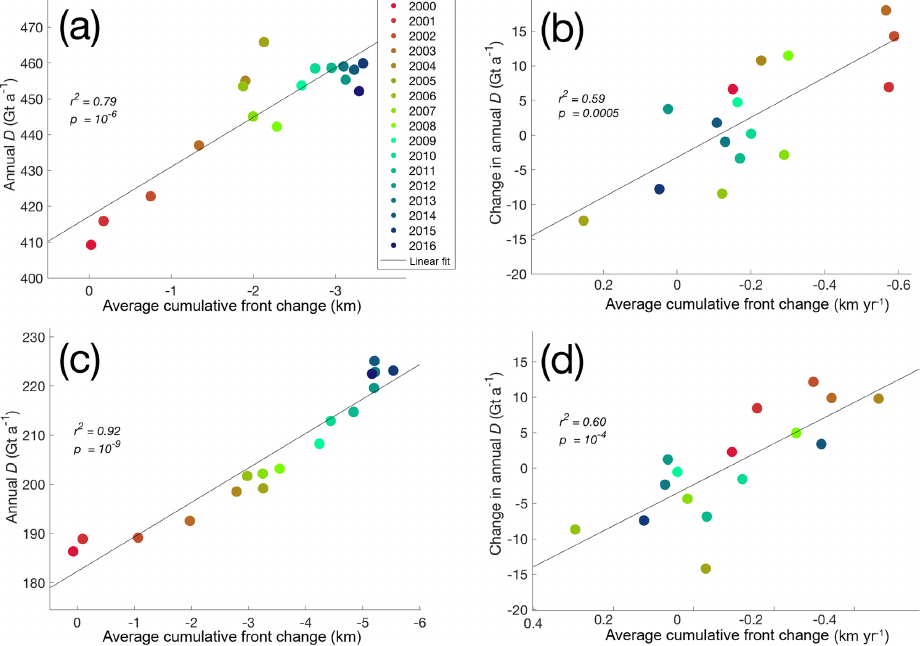
Figure 5. (a) Colored dots are GrIS-wide cumulative average front position change since 1 January 2000, with negative values indicating retreat, versus annual average discharge, D , for each year between 2000 and 2016. The black line is the linear best fit to the data points, with the variance ( r 2 ) and probability value ( p ) of the fit labeled. (b) The average rate of front position change, with negative values indicating retreat, for each year versus the change in average annual discharge between years. (c) Same relationship described in (a) , but for glaciers in the NW region only. (d) Relationship between average front position change and the change in annual D from the current to the following year ( D i + 1 − D i ). Date color scale and statistics for (b) , (c) , and (d) are as described for (a)